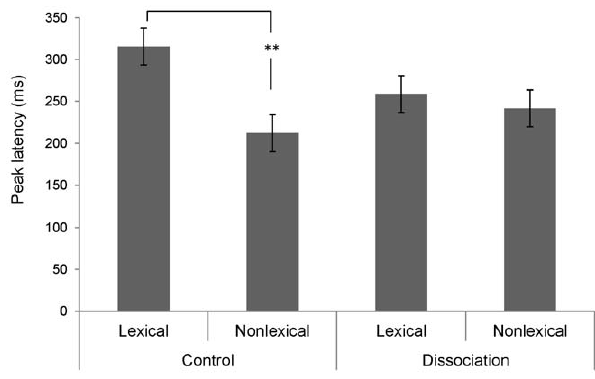
Figure 3. P3a peak latency (post-divergence point) of different participant group and syllable type conditions. Note . Lexical= lexical syllable, nonlexical=nonlexical syllable, control=control group, dissociation=dissociation group, **= p , .01.